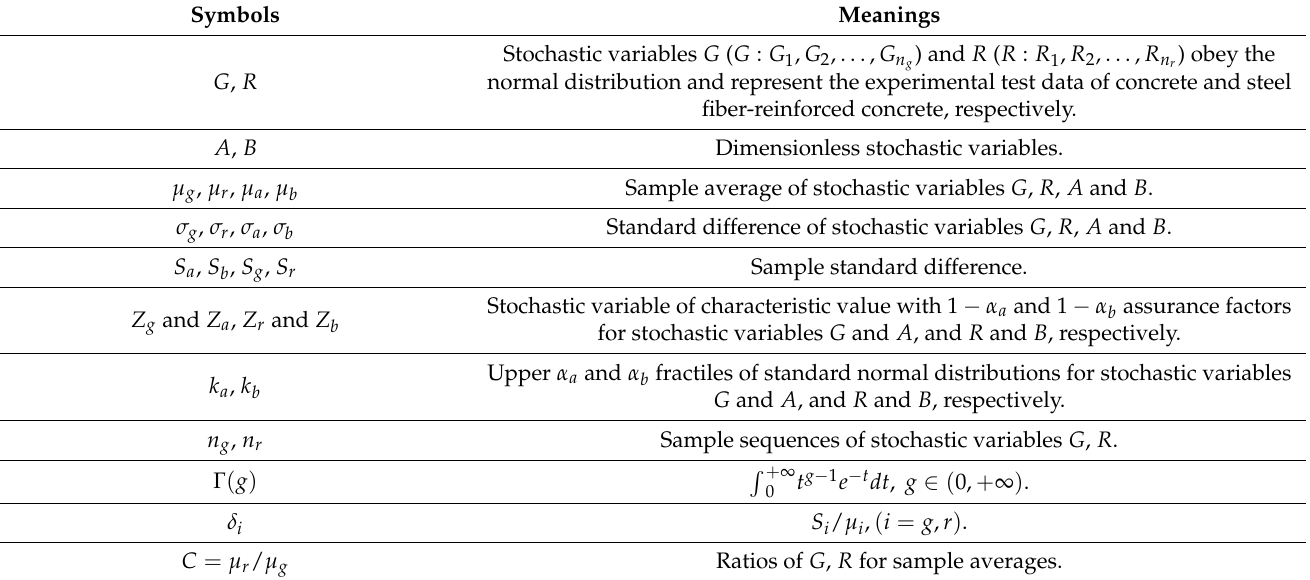
Table 6. Symbols and